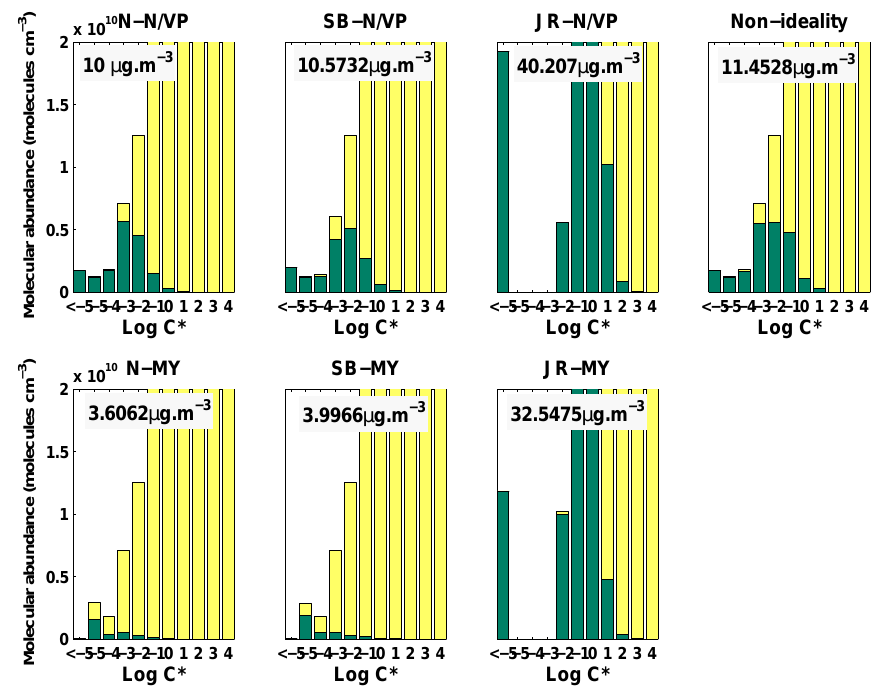
Fig. 6. Predicted binned component volatility for a 10000 compound representation of one example functionality distribution set. The abscissa is the base 10 logarithm of the saturation concentration of the components in the respective volatility bin. The green bars correspond to the particulate and the yellow to the vapour phase. The total condensed mass is indicated on each panel